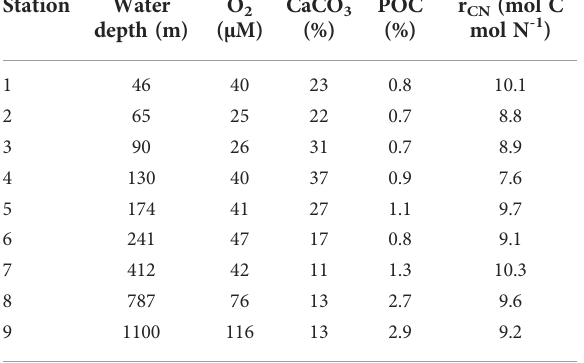
TABLE 1 Mean contents of POC, CaCO 3 and the C:N ratio in the sediment cores recovered from each station along with mean bottom water O 2 concentrations recorded on the BIGO landers.